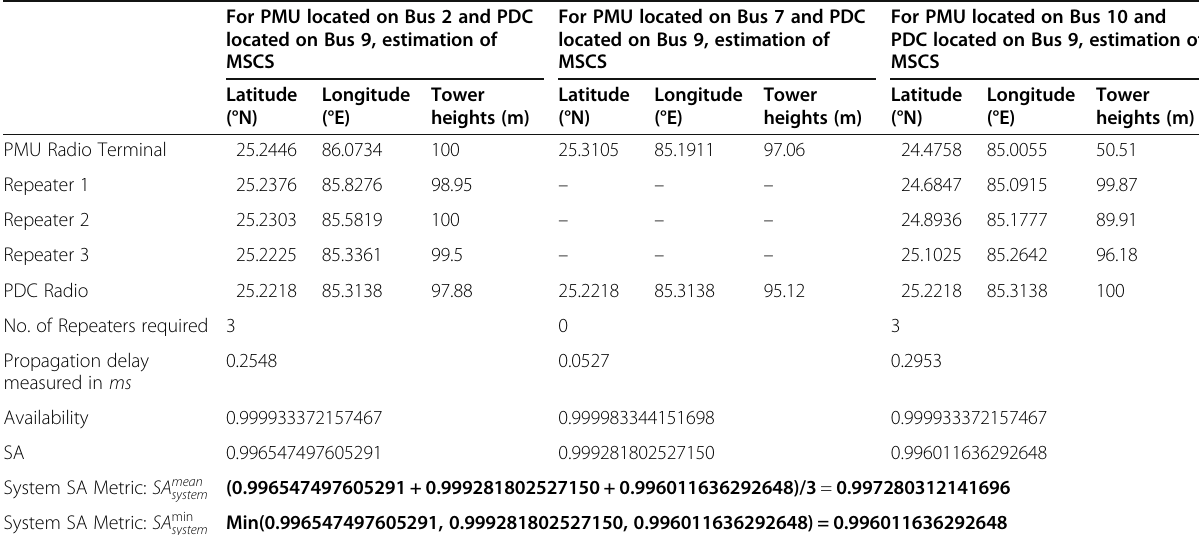
For PMU located on Bus 7 and PDC located on Bus 9, estimation